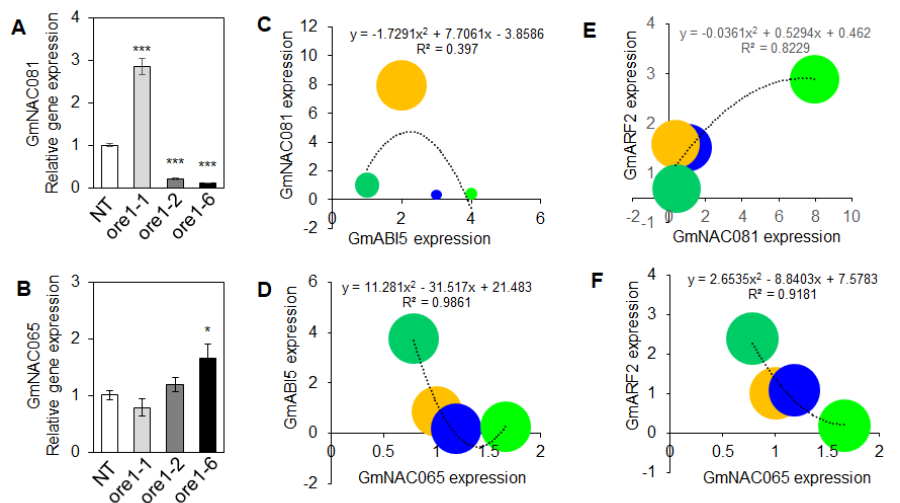
Figure 5. Expression of NAC transcription factors and correlation between NAC expression and hormone signaling in soybean transgenic plants. NAC transcription factors including ( A ) GmNAC081 and ( B ) GmNAC065 expression in the detached leaves of wild-type (NT) and transgenic lines.